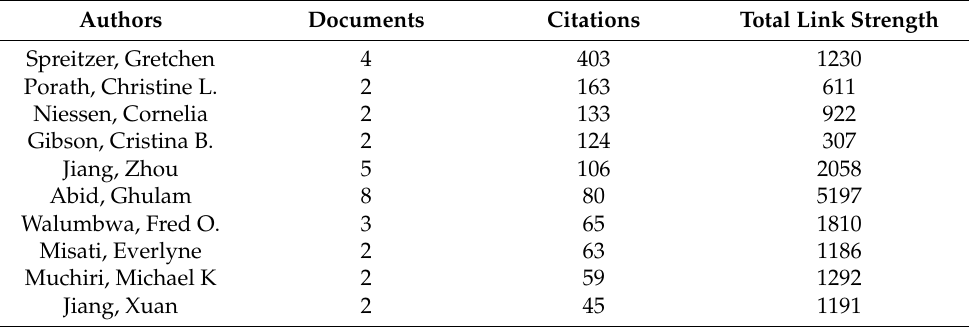
Table 10. The 10 most representative authors by bibliographic coupling analysis.